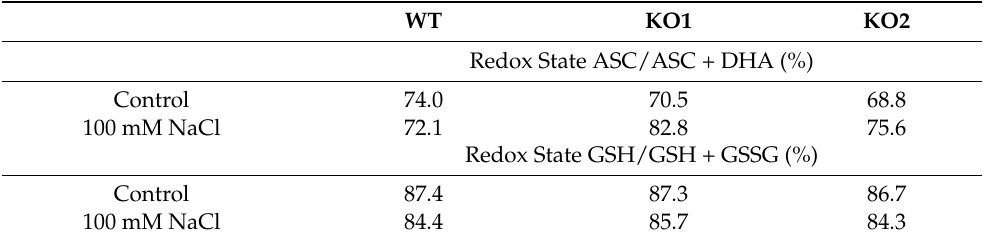
Table 1. Redox state of ascorbate and glutathione in leaves of A. thaliana wild type (WT) and two lines of KO Attrxo1 plants grown under control conditions and in the presence of 100 mM of NaCl. Redox state was calculated as ASC/ASC + DHA and GSH/GSH + GSSG percentages.